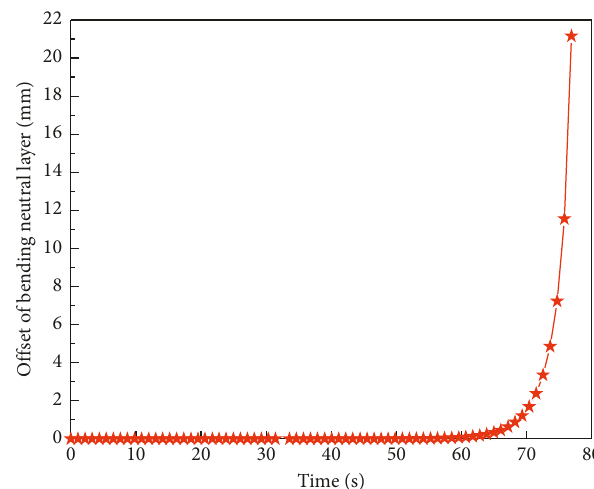
Table 1: Parameter fitting values of A